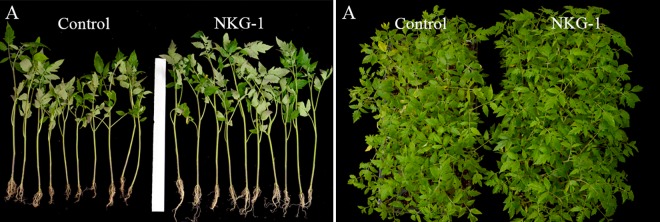
Effect of B. methylotrophicus NKG-1 fermentation broth on the development of roots and whole tomato seedlings in a greenhouse with five irrigation events during 2 months.(A) effect on root development. (B) effect on whole plant development.